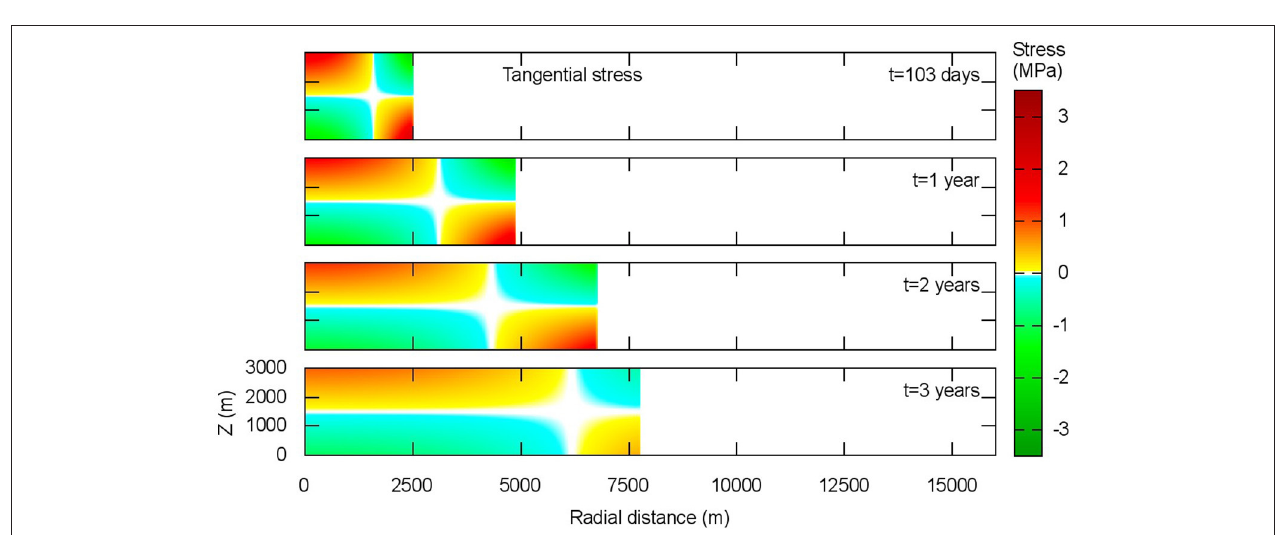
FIGURE 9 | The distribution of the radial stress ( σ rr ) in the elastic plate at four different times (103 days, 1 year, 2 years, and 3 years). Red indicates traction and green indicates compression.